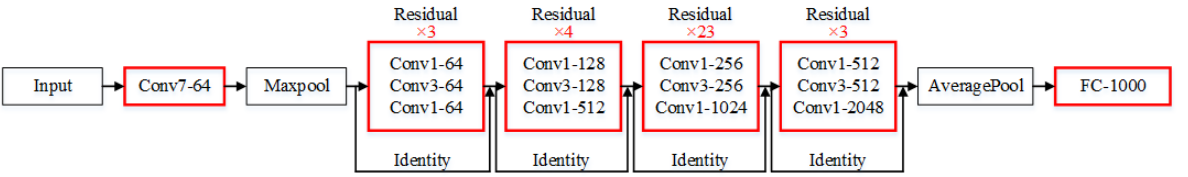
Figure 4. The ResNet101 structure.